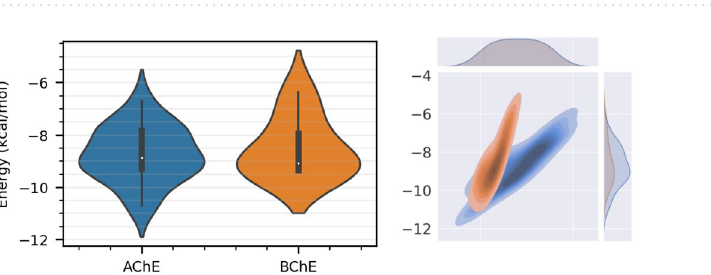
Figure 3. Compound 1 ’s molecular docking revealed a network of H bonds, which are shown as dashed lines.